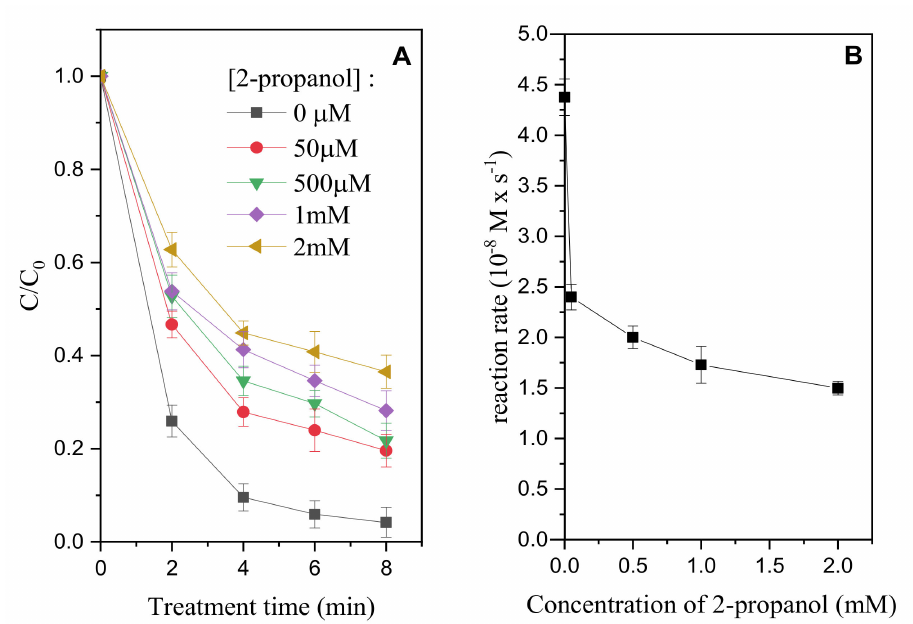
Figure 2. Degradation profiles of methylene blue (MB) (initial concentration 10 − 5 M) in the presence of increasing concentrations of 2-propanol, treated in the PG reactor ( A ). Evolution of the reaction rate for MB degradation in presence of increasing concentration of 2-propanol (0–2 mM range) ( B